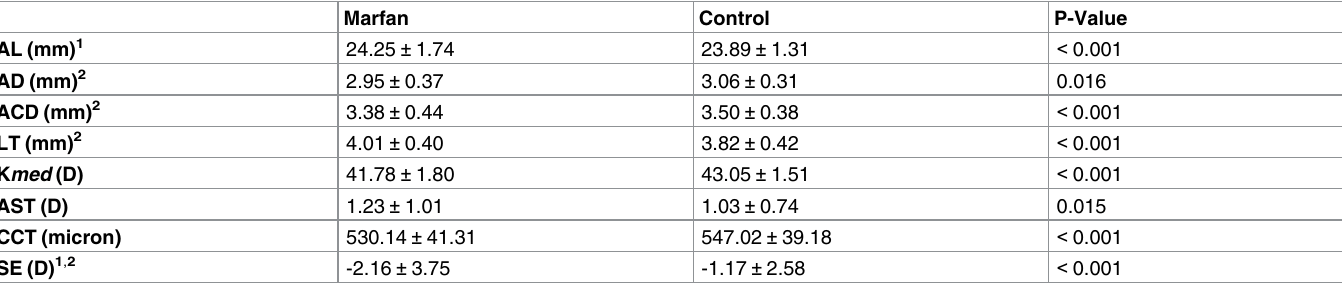
Table 1. Biometry, dimensions and refractiveerror of eyes of Marfan patients and control